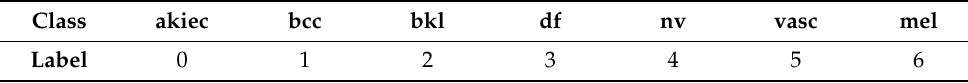
Figure 2. Overview of the proposed ESRGAN-based CNN algorithm. Table 2. Notations for each class in the HAM10000